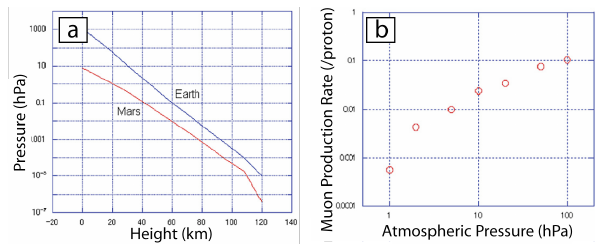
Figure 3: From Tanka [2007]. (a) Terrestrial and Martian atmospheric pressure profile. (b) Fig. 3. From Tanka (2007). (a) Terrestrial and Martian atmospheric Estimation of muon production rate on Mars per incident proton, integrating over the zenith from -90˚ to 90˚, at Martian surface as a function of the atmospheric thickness for primaries pressure profile. (b) Estimation of muon production rate on Mars between 1 and 20 GeV. For muons between 20 GeV and 5 TeV the production rate is over 10 per incident proton, integrating over the zenith from − 90 ◦ to 90 ◦ , times greater at all pressures. at Martian surface as a function of the atmospheric thickness for primaries between 1 and 20GeV. For muons between 20GeV and 5TeV the production rate is over 10 times greater at all pressures.